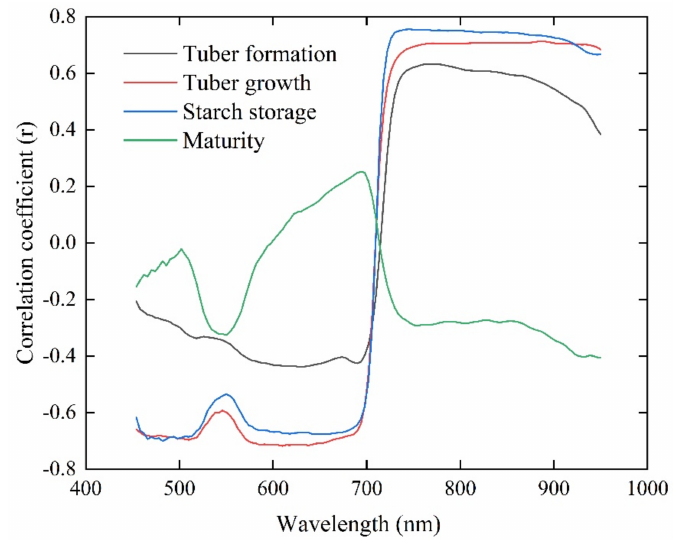
Figure 5. Correlation coefficient between potato canopy spectra and